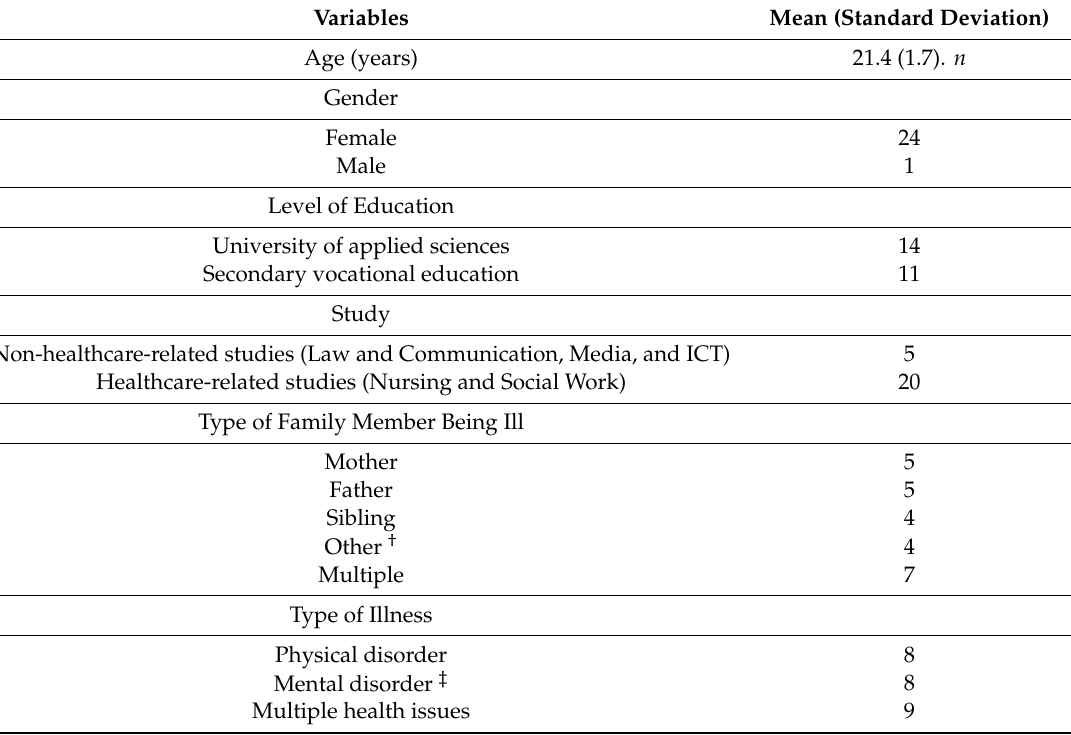
Table 1. Demographic data of the participants who attended a focus